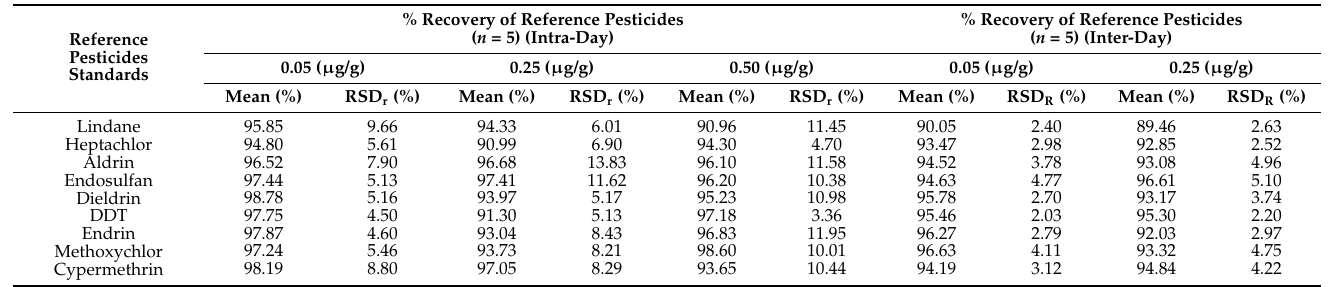
Table 1. Mean recovery (%) (accuracy) and RSD (%) (precision) of the selected reference pesticides in the fish matrix at different fortification levels.